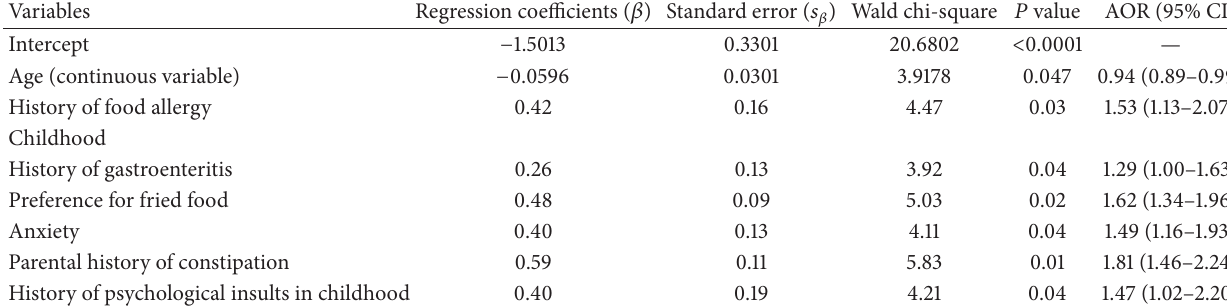
Table 2: Multivariate logistic regression analysis of risk factors of IBS in